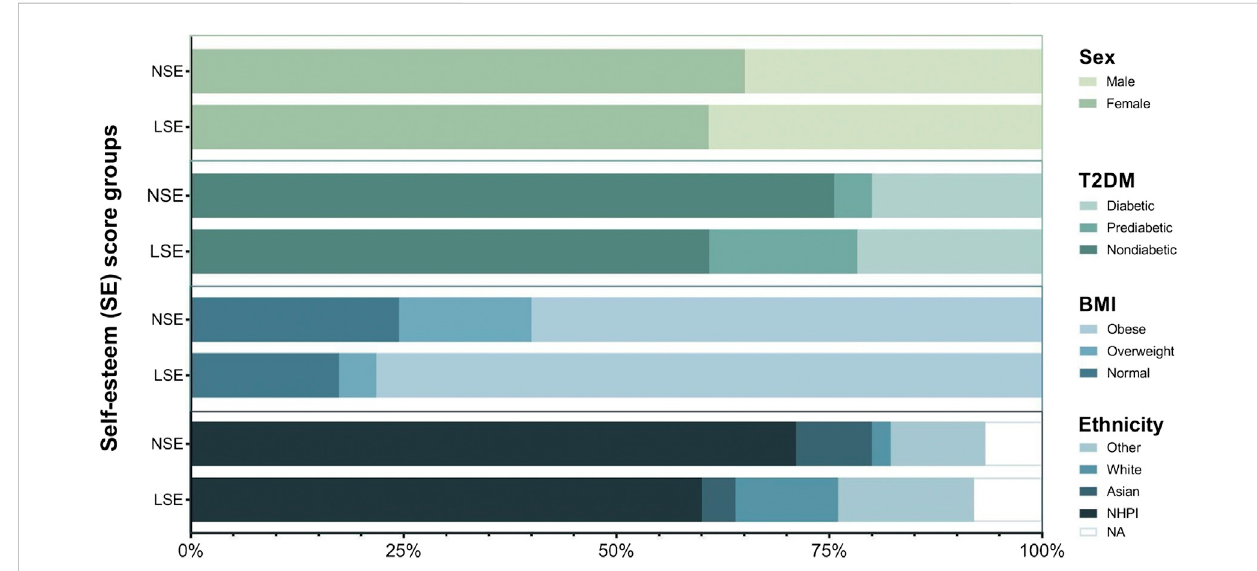
FIGURE 2 Graphical summary of biometric and sociodemographic category distribution across SE groups. Chi-squared tests were performed between SE groups to assess the independence of categorical distribution for sex ( p = 0.914), T2DM ( p = 0.228), BMI ( p = 0.287), and ethnicity ( p =